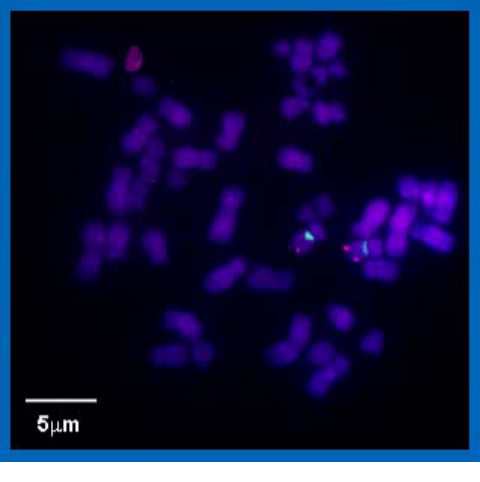
Figure 2. Example of a lymphocyte metaphase spread after a two-color experiment with the repetitive centromere 9 PNA COMBO-FISH probe (green signals: OregonGreen 488  , λ = 496/524 nm) and a 9q subtelomere (9qtel) DNA standard FISH probe (red signals: ex/em rhodamine, λ = 546/580 nm). For DNA counterstaining TOPRO-3-iodide was ex/em